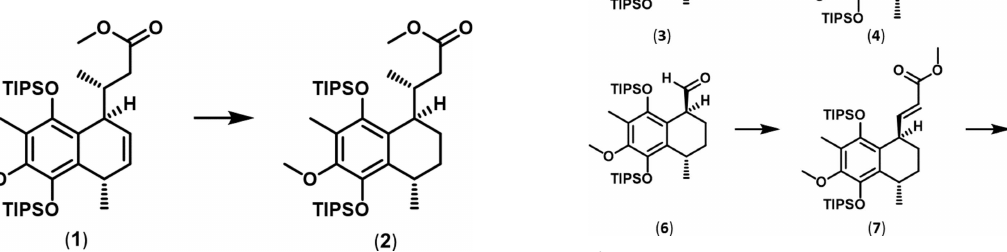
Figure 6 Synthesis scheme to obtain compound ( 2 ).